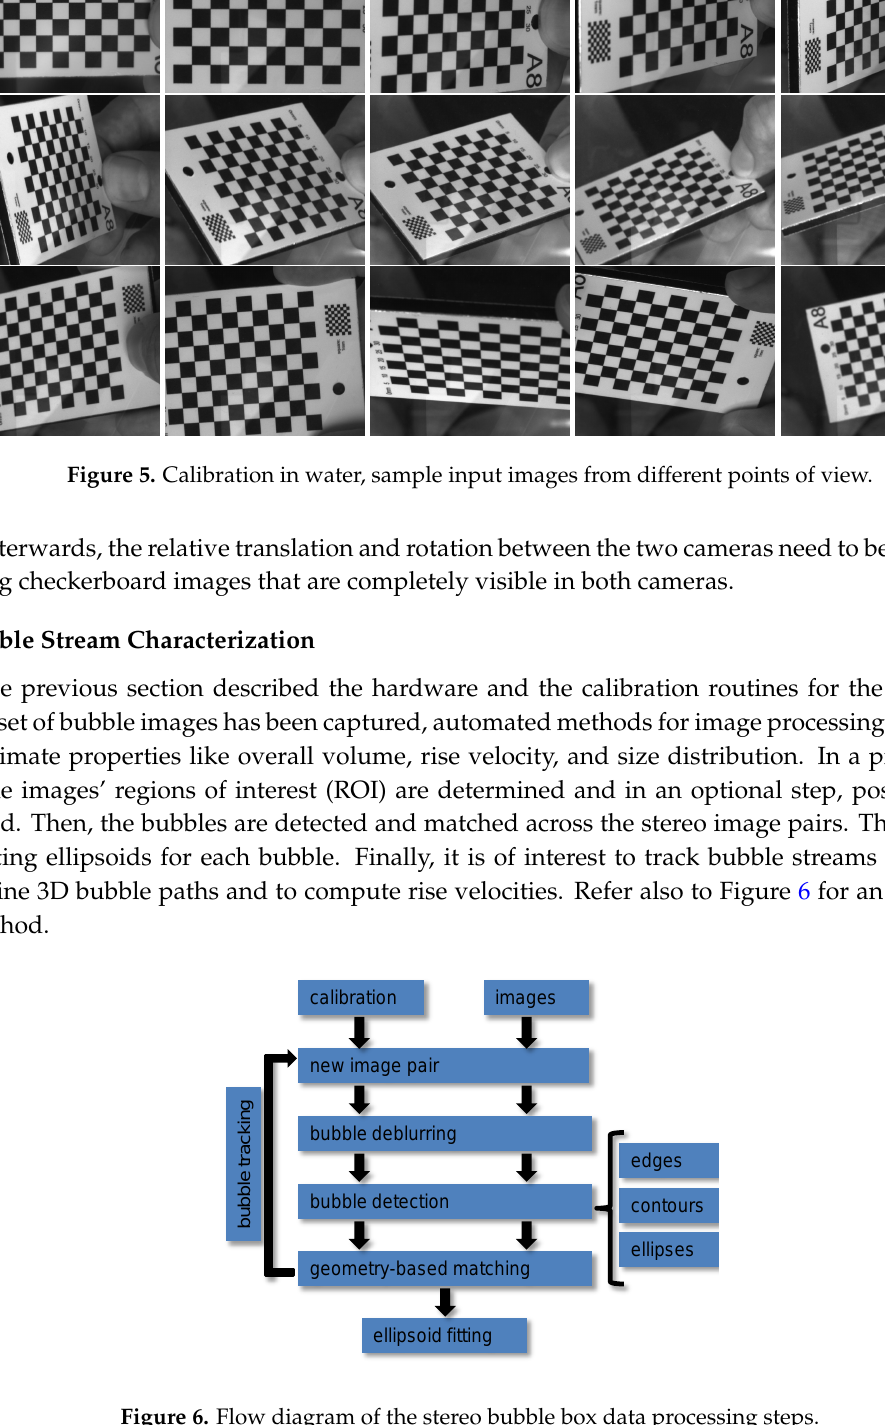
Figure 6. Flow diagram of the stereo bubble box data processing